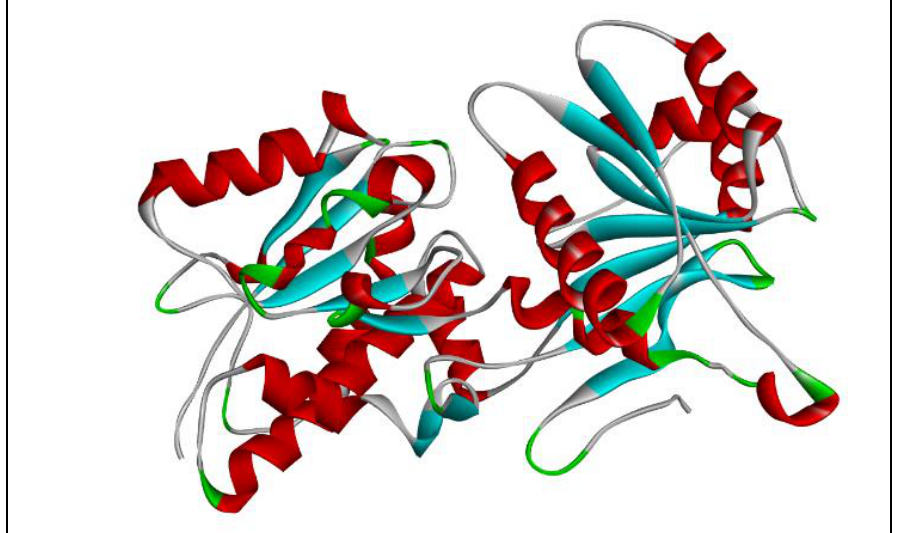
Figure 1. 3D model of ECD generated by SWISS MODEL workspace.